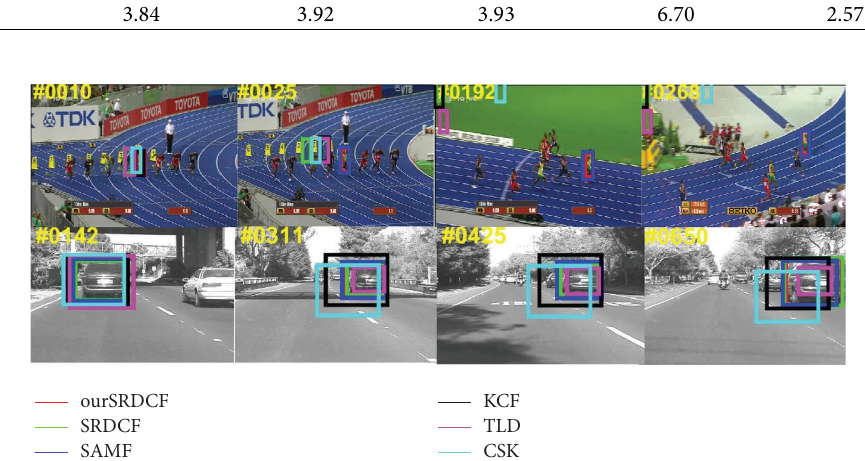
Figure 8: Comparison of tracking results of six algorithms in “bolt” and “car4” video